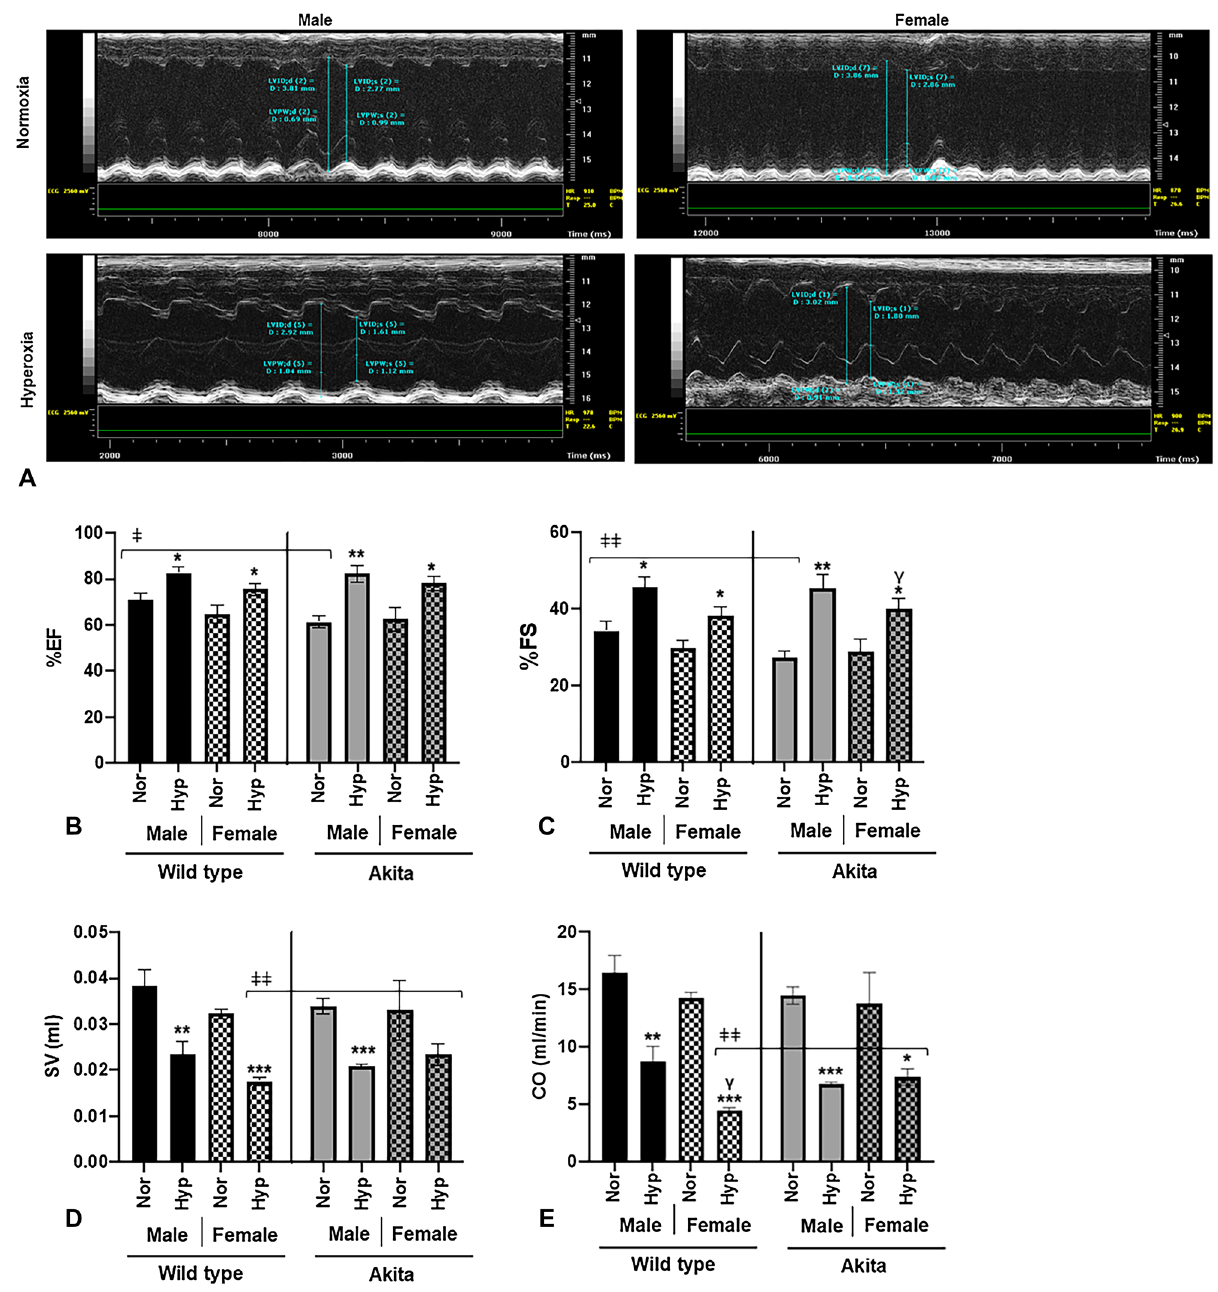
Figure 2. Akita mice display distinct functional parameters compared to WT mice ( A ) percent ejection fraction (FS), ( B ) percent fractional shortening (EF), ( C ) stroke volume (SV), and ( D ) cardiac output (CO) in hyperoxia/normoxia treated Akita and wild type mice, ( E ) Optical traces for male and female Akita mice in normoxic and hyperoxic conditions . Error bars represent ± SEM. *p < 0.05, **p < 0.005 ***p < 0.0005. *compares effects of hyperoxia and normoxia of same gender and strain; Y compares male and female mice of the same strain and treatment; ‡compares WT and Akita of same gender and